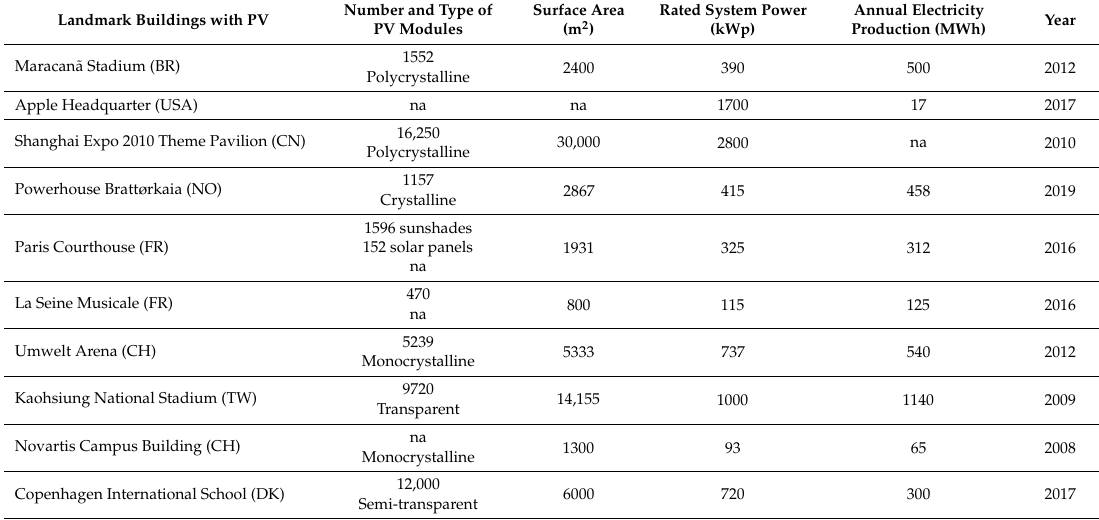
Figure 14. Copenhagen International School (a top view and elevation: Source of illustration Google Earth, Google 2020) ( on top ). Integration and characteristic of PV systems ( on the bottom ). Table 2. Total number and type of PV modules, installed capacity and annual electricity production for the ten landmark buildings.